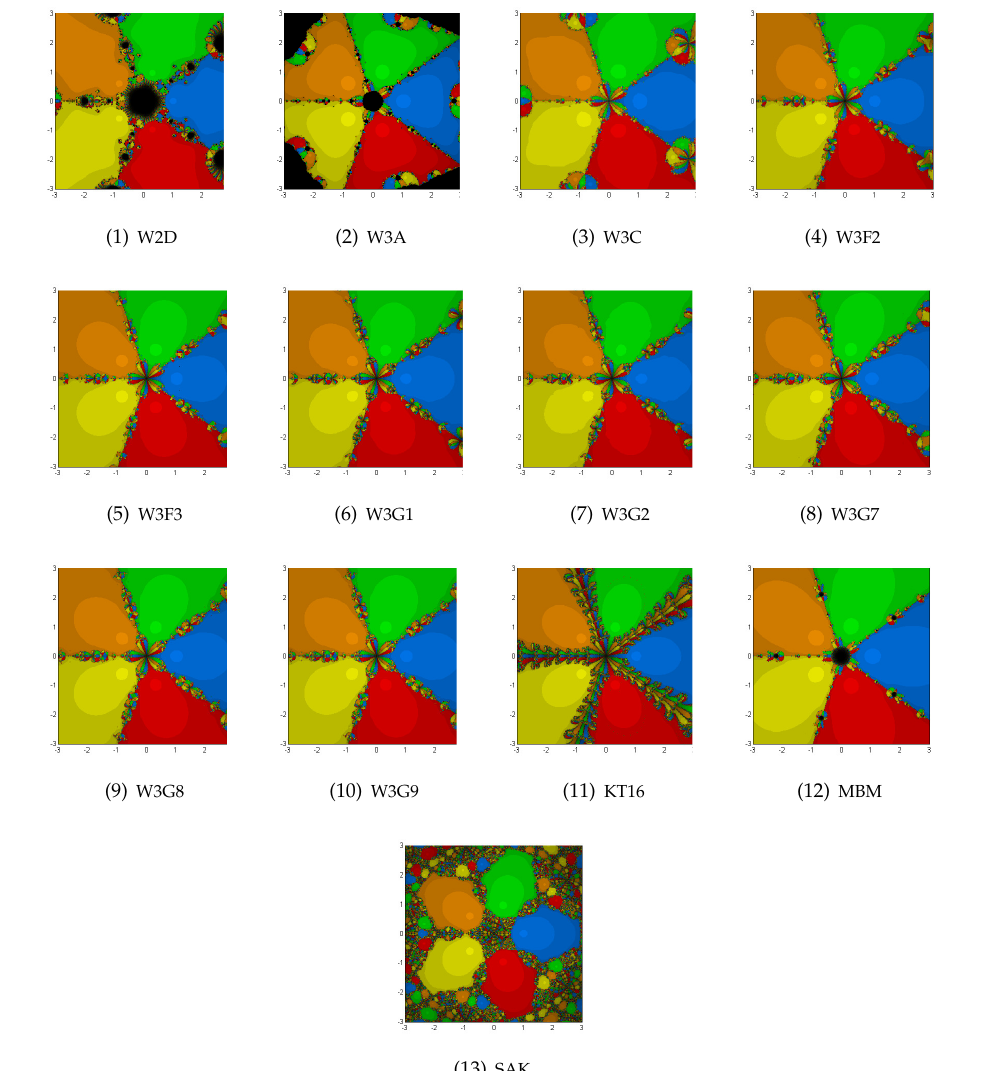
Figure 5. The top row for W2D (left), W3A (center left), W3C (center right) and W3F2 (right). The second row for W3F3 (left), W3G1 (center left), W3G2 (center right) and W3G7 (right). The third row for W3G8 (left), W3G9 (center left), KT16 (center right) and MBM (right). The bottom row for SAK (center), for the roots of the polynomial equation ( z 5 − 1 )